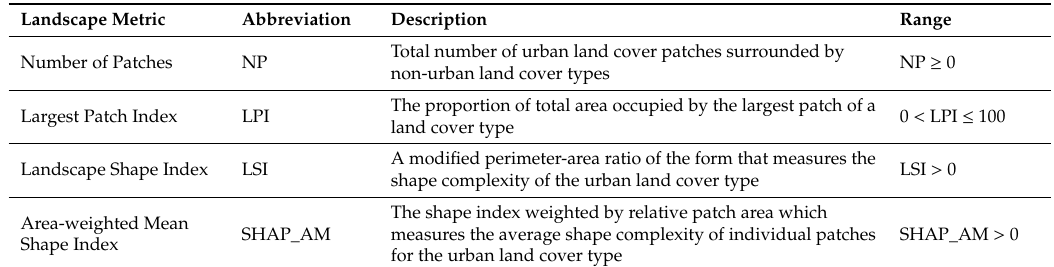
Table 3. Landscape metrics based on McGarigal and Marks (1995)